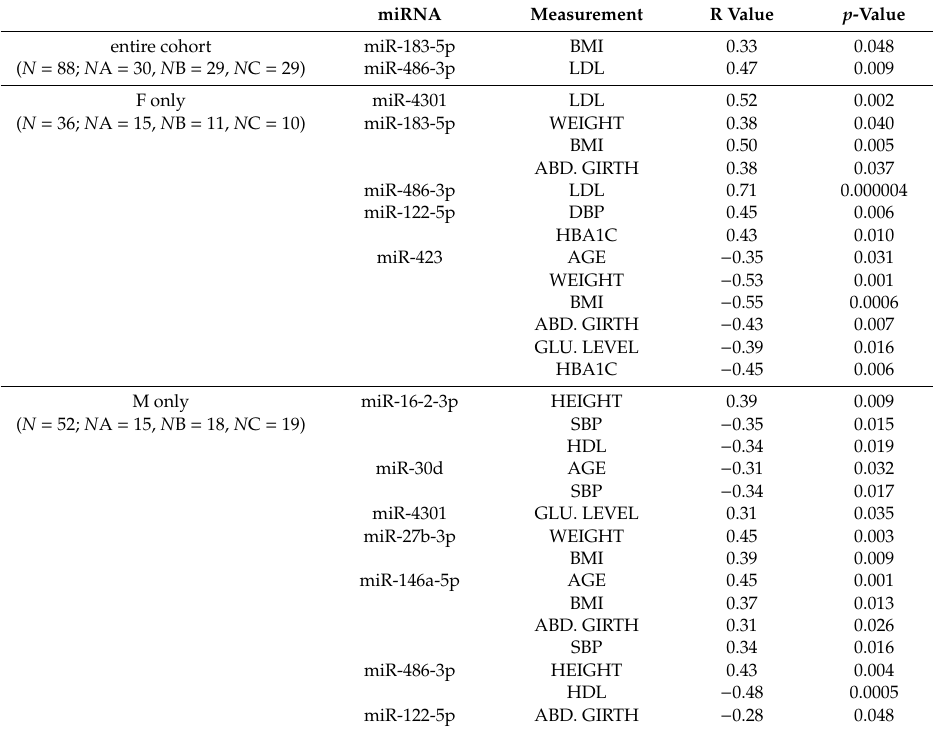
Table 3. Summary of significant ( p < 0.05) Pearson correlations between plasma miRNA levels and clinical measurements as indicated. F—female, M—male. NA refers to the number of subjects in group A,